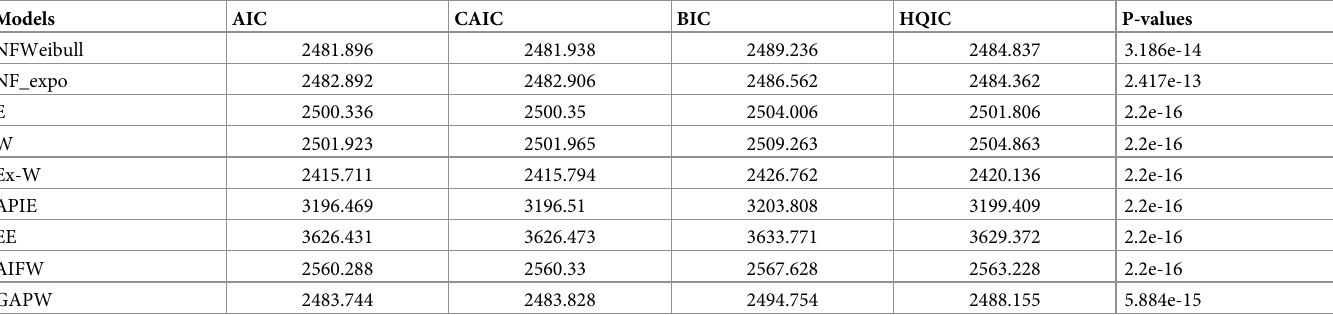
Table 8. Goodness of fit measures for Covid-19 data of Afghanistan.